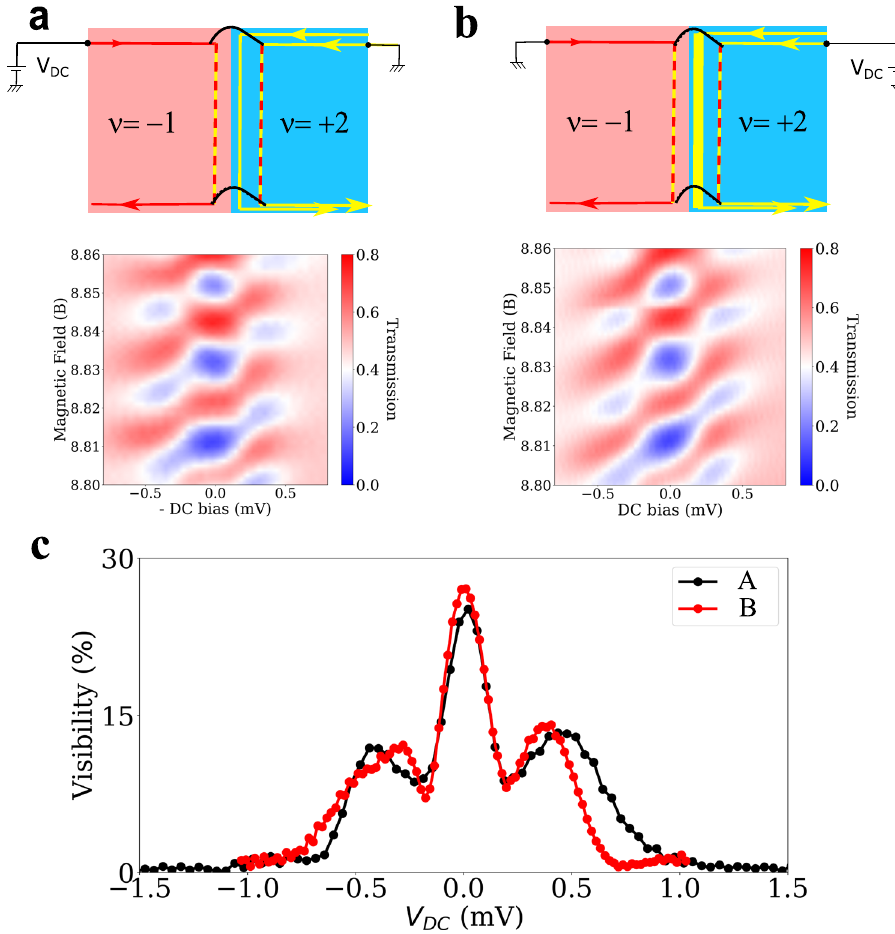
Fig.4|Dependenceoflobepatternonthebeamsource. Transmission T MZ ofthe large interferometer at ( ν n , ν p ) = (2, − 1) as a function of the magnetic fi eld and the DC bias V DC appliedto a the upperright ohmiccontactor b the upper left contact. In a (resp.( b )),electronbeamisinjected fromtheNregionof ν n = 2 (resp.Pregion of ν p = − 1 )totheinterferometer,biasingthetwo(resp.single)edgechannelsofthe